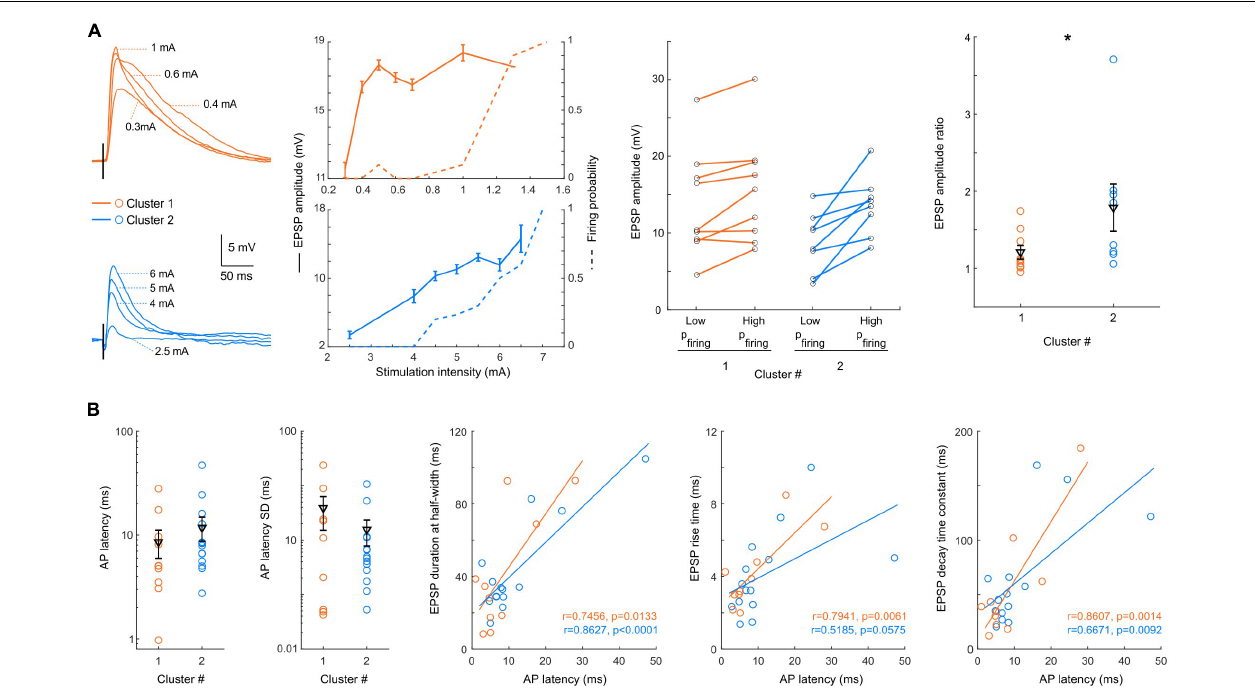
FIGURE 5 | Input/output and suprathreshold response to L2/3 stimulation. (A) Left: example of EPSPs (smoothed average of 10 stimulations excluding spiking events) recorded in a cluster 1 (orange) and a cluster 2 (blue) neuron in response to increasing stimulation intensity of layer 2/3, with the EPSP amplitude and probability of firing plotted as a function of stimulation amplitude for these example neurons. Center: for each neuron, the amplitude of EPSPs is plotted for a low stimulation intensity (last intensity before spiking is evoked) and a high stimulation intensity (spiking probability of 0.7–0.9). Right: the ratio between EPSP amplitudes at high/low stimulation amplitudes is significantly lower in cluster 1 neurons ( p = 0.04). (B) From left to right: mean latency, and SD of the latency of spikes evoked by suprathreshold stimulation. Significant correlations are observed between the spike latency in suprathreshold responses and the kinetics (duration at half-width, rise time and decay time constant) of subthreshold EPSPs. All data: mean ± SEM. * p <